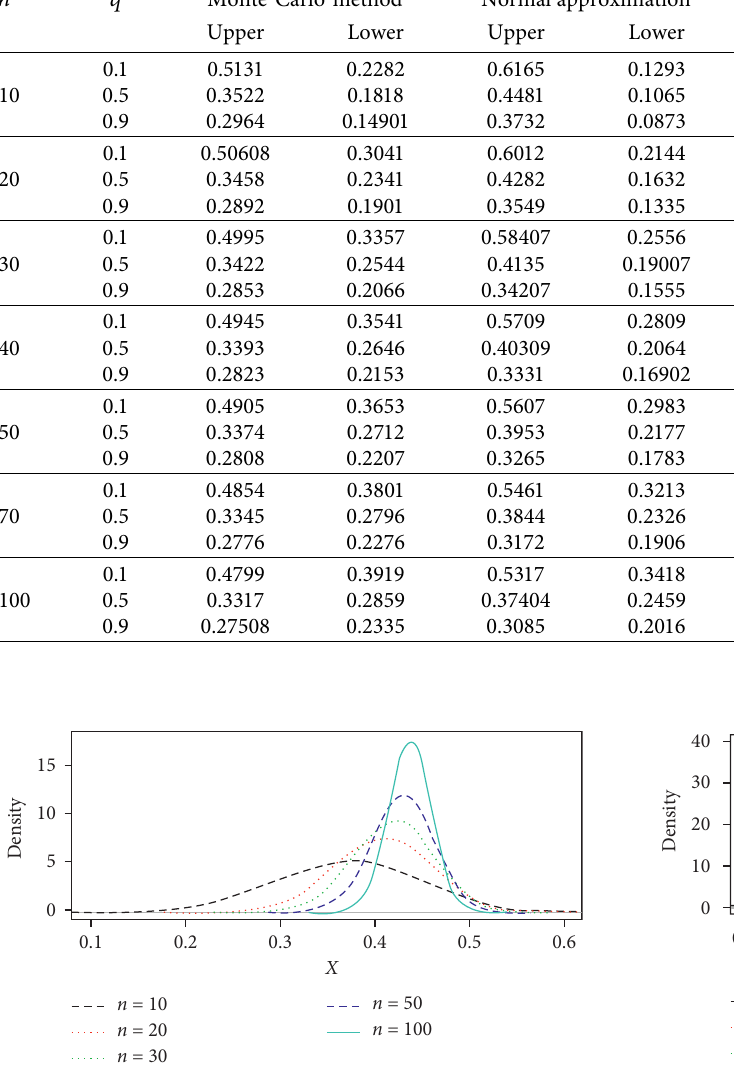
n based on U (0, 1).